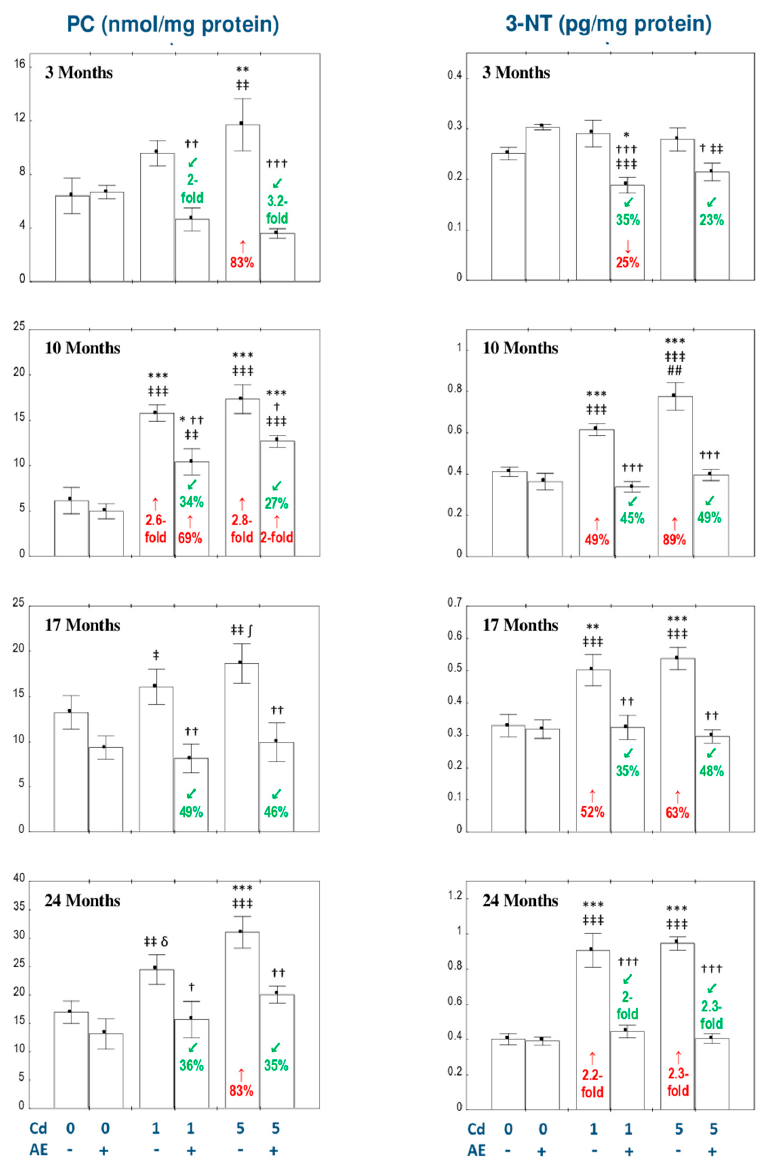
Figure 2. The influence of the extract from Aronia melanocarpa L. berries (AE) on the concentrations of protein carbonyl groups (PC) and 3-nitrotyrosine (3-NT) in the liver of female rats exposed to cadmium (Cd). The females were given Cd in the diet at the concentration of 0, 1, and 5 mg Cd/kg and/or 0.1% aqueous AE (+) or not (-). Data are represented as mean ± SE for 8 animals, except for 7 females in the AE, Cd 1 , and Cd 5 groups after 24 months. Statistically significant differences (ANOVA, Duncan’s multiple range post hoc test): * p < 0.05, ** p < 0.01, *** p < 0.001, δ p = 0.05, ∫ p = 0.06 vs. control group; † p < 0.05, †† p < 0.01, ††† p < 0.001 vs. appropriate group treated with Cd alone; ‡ p < 0.05, ‡‡ p < 0.01, ‡‡‡ p < 0.001 vs. group administered with AE alone; ## p < 0.01 vs. appropriate group receiving the 1 mg Cd/kg diet alone. Numerical values in bars or above the bars disclose the percentage changes or factors of changes in comparison to the control group ( ↑ , increase; ↓ , decrease) or the appropriate group given Cd alone ( (cid:46) ,